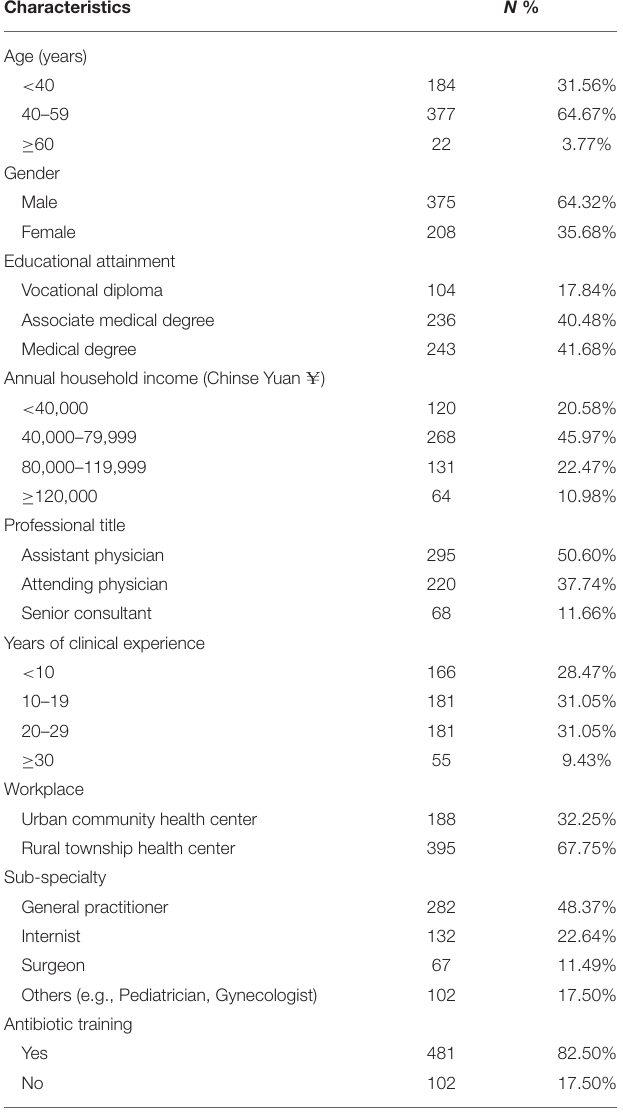
TABLE 1 | Characteristics of physician respondents ( n = 583). TABLE 2 | Strategies adopted by study participants ( n = 583) in response to diagnostic uncertainty.